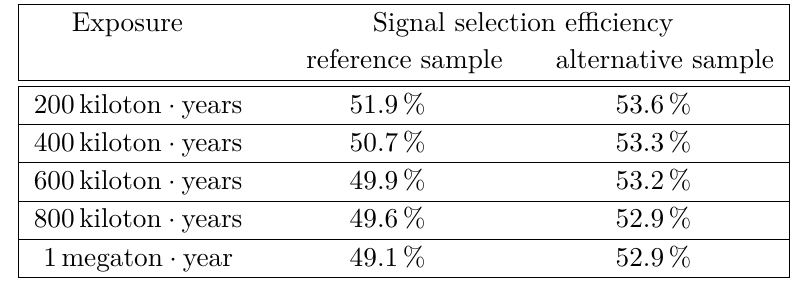
Table 4 . Signal selection efficiencies in the reference and alternative samples with neural network cut 4.1 of the final event selection tuned for B = 0 . 5 background events at selected